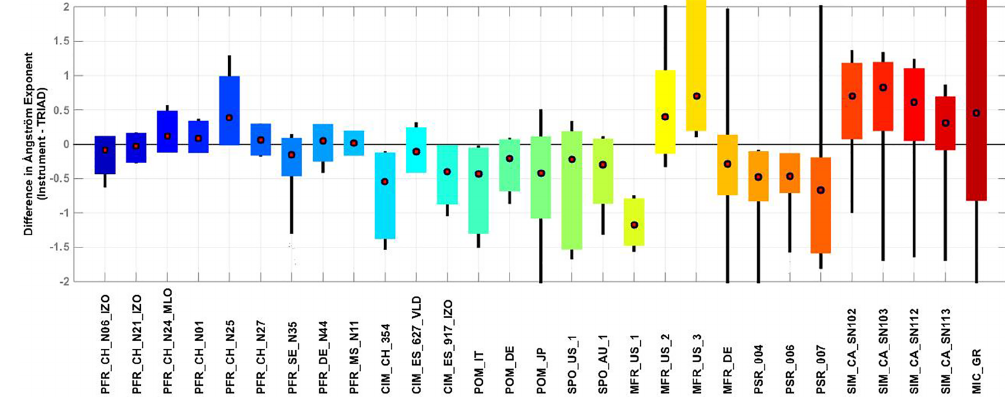
Figure 6. Difference in the Ångström exponent between each instrument and the WORCC triad. The boxes represent the 10th and 90th percentiles, while the black lines represent the minimum and maximum values of the distribution excluding the outliers. Outliers (gray dots) are considered to be values outside the 10th and 90th percentiles by 4 times the width of the distribution at a 10% level. Box colors are only used to differentiate between